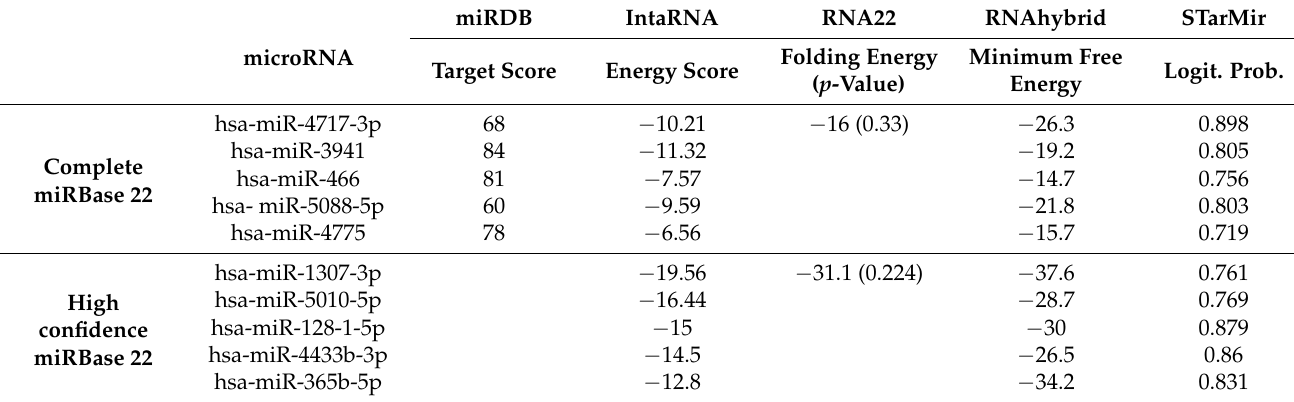
Table 1. Prediction scores of selected microRNAs. The table shows the values of miRDB target score, IntaRNA energy score (E), RNA22 folding energy and p -value, RNAhybrid minimum free energy (mfe), and STarMir logistic probability (Logit.Prob.) of the 10 chosen microRNAs. miRDB IntaRNA RNA22 RNAhybrid STarMir Folding Energy Minimum Free microRNA Logit. Target Score Energy Score ( p -Value) Energy